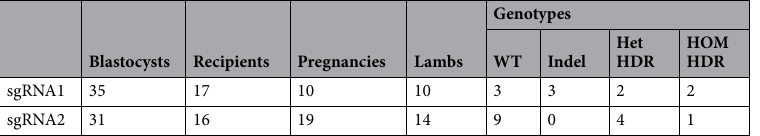
Table 1. Editing the sheep PPT1 locus. Details of blastocysts, recipients, pregnancies and the geneotypes of liveborn offspring for each sgRNA. WT: wild type; Indel: insertion and/or deletion; Het HDR: heterozygous homology dependant repair; Hom HDR: homozygous homology dependent